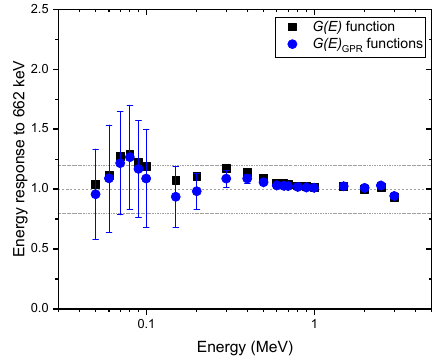
Figure 9. Comparison of energy response normalized to the energy of 622 keV, estimated with G ( E ) functions, and the G ( E ) function for the spectra obtained under isotropic geometry. The error bar shows a 95% confidence interval.